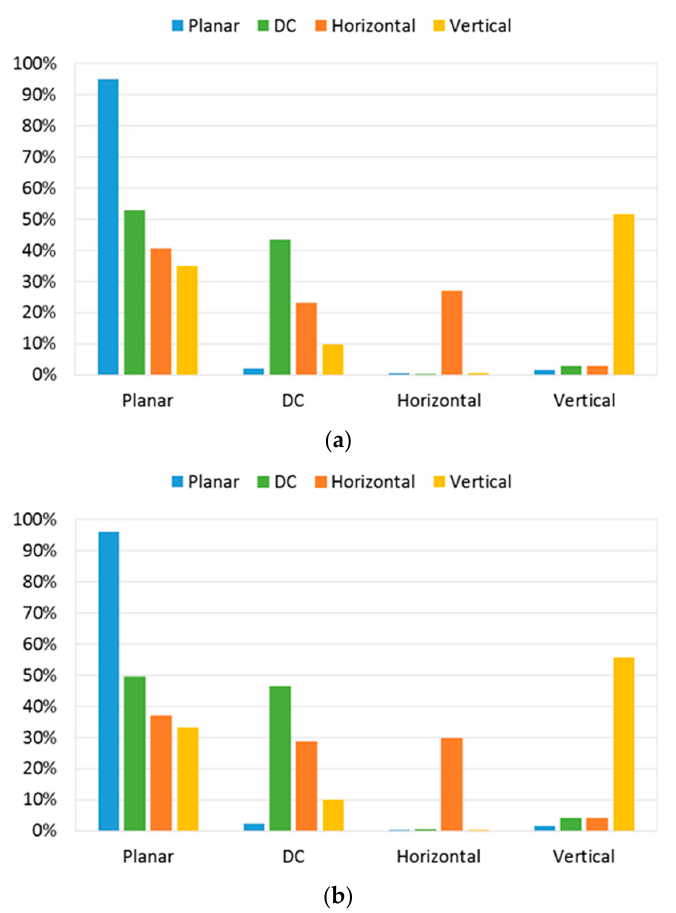
Figure 6. Correlation between the optimum mode and the minimum SATD cost mode for QPs of ( a ) 39 and ( b ) 42.